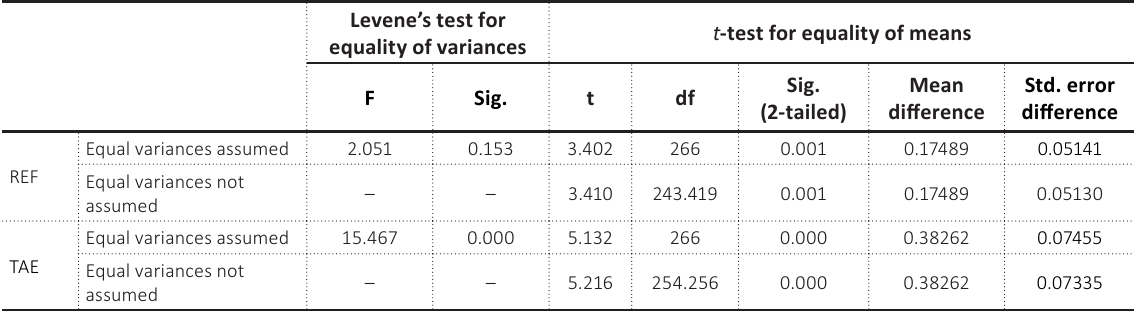
Table 8. Test results of the differences between